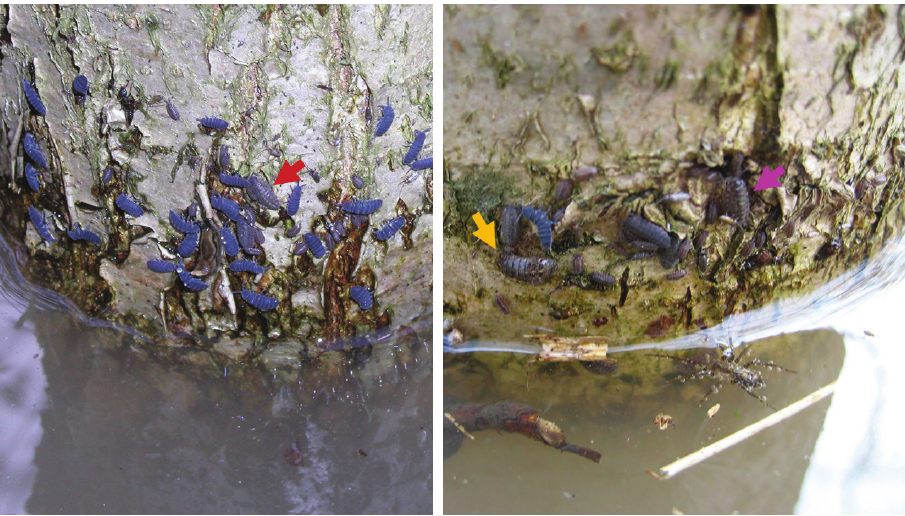
Figure 1. Springtails and terrestrial isopods climbing on tree trunks to avoid drowning during a spring flood. Trachelipus rathkii (Brandt, 1833), indicated by pink arrow, Protracheoniscus politus (C. L. Koch, 1841), indicated by orange arrow, and Porcellium conspersum (C. L. Koch, 1841), indicated by red arrow, are visible. Litovelské Pomoraví PLA (Czech Republic), 30 March 2006 (photographs